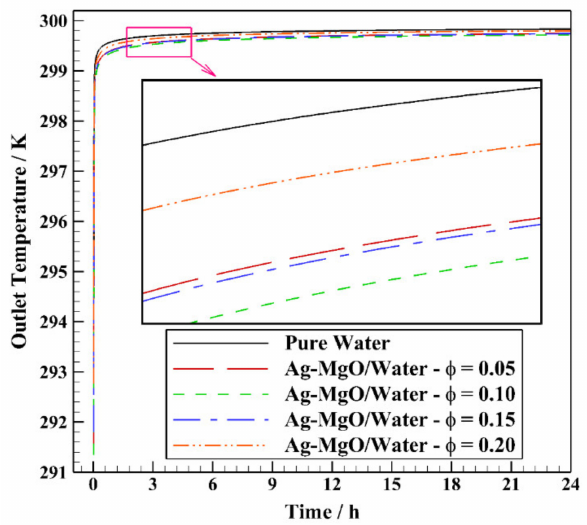
Figure 10. The variation of the outlet temperature with operating time using Ag-MgO/water hybrid nanofluid with different volume fractions at Re =